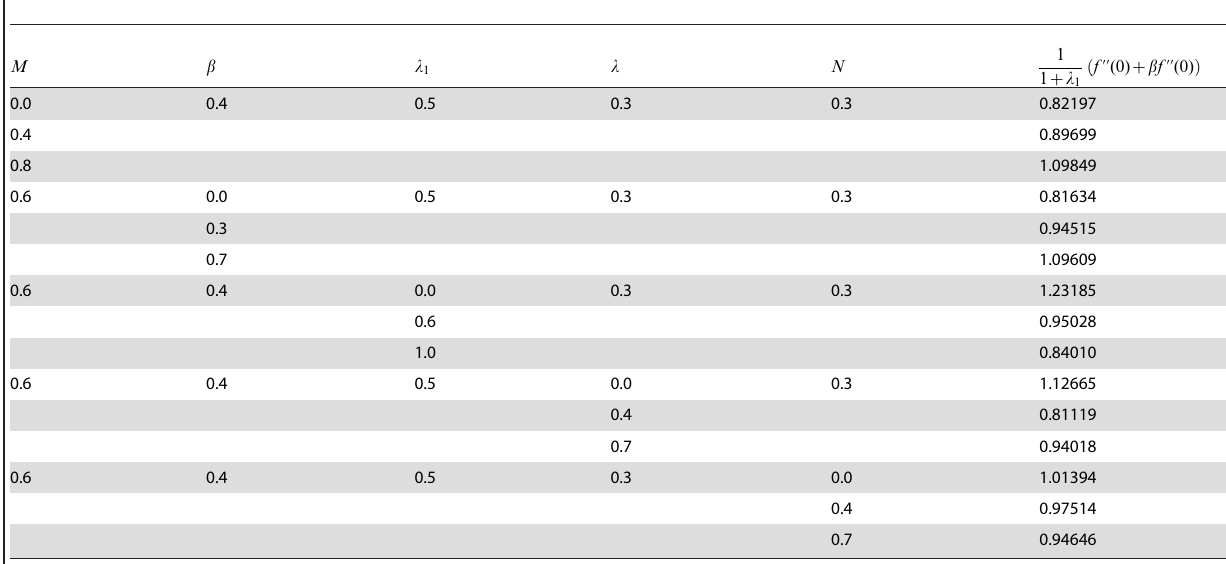
Table 2. Values of skin-friction coefficient